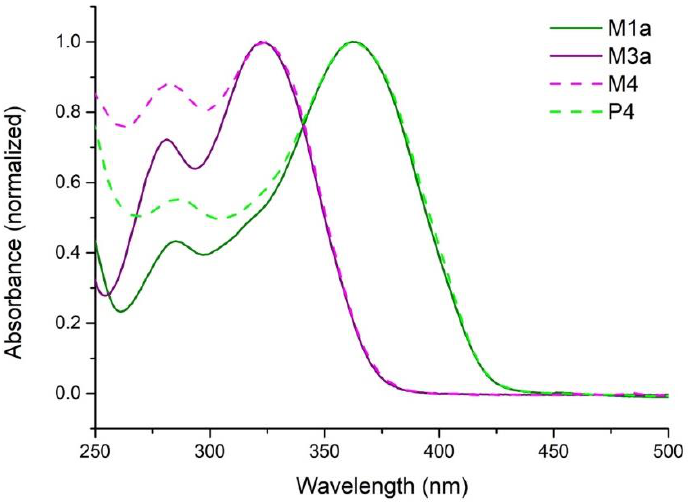
Figure 8. Absorbance spectra of M1a , M3a , M4 and P4 in methylene chloride (10 − 2 g/L).